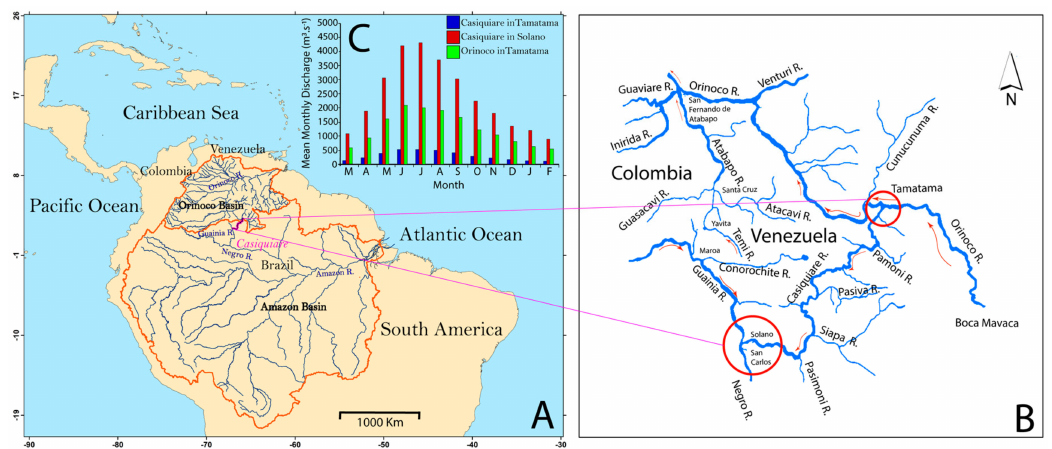
Figure 1. ( A ) Location map of the Casiquiare natural channel, connecting the Orinoco and Amazon basins. ( B ) Close view of the fluvial system showing main tributaries of the Casiquiare Channel. ( C ) Mean hydrographs of the Casiquiare channel (in Tamatama and Solano) and the Orinoco River in Tamatama, using discharge data from the period